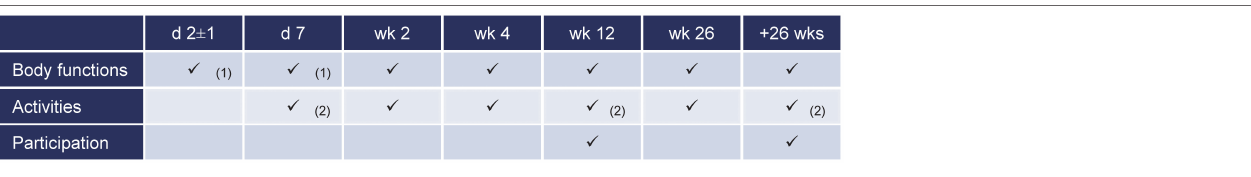
TABLE 3 | Measurement time points of the core set for clinical motor rehabilitation after